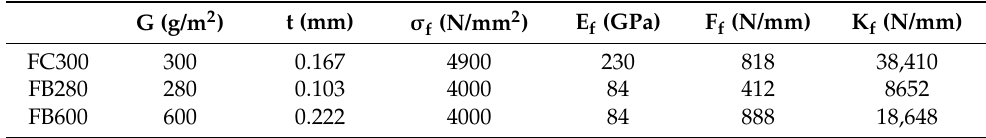
Table 1. Geometrical and mechanical characteristics of the fabrics